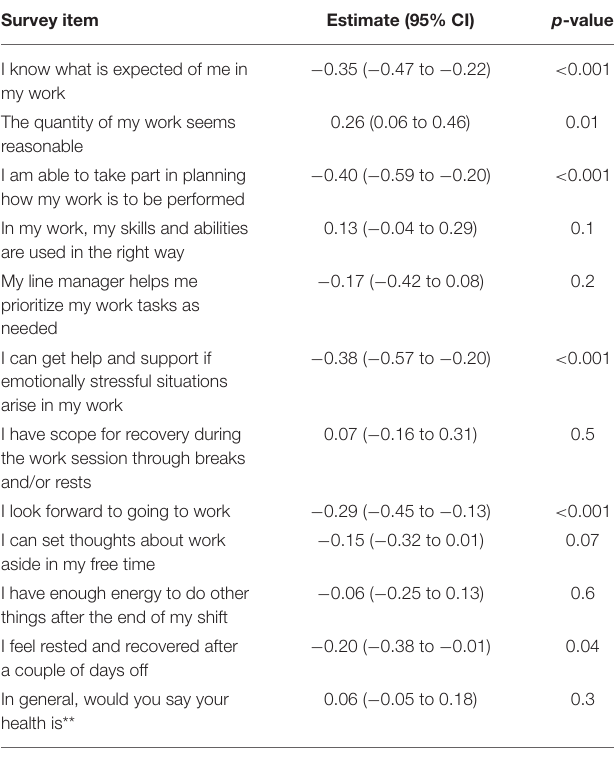
TABLE 2 | Overall effects of the COVID-19 pandemic on working conditions and possibility for recovery compared to the situation before the pandemic. Survey